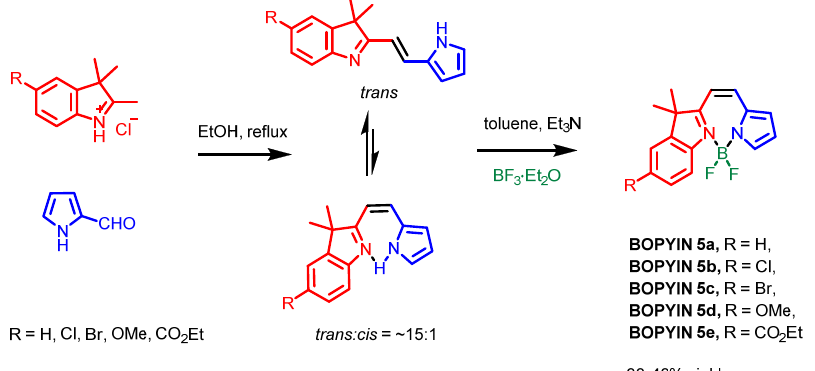
Figure 4. Confocal microscopy colocalization images of HeLa cells stained with BODIPYs 3 and 4 , and MTG. ( a , d ) MTG under a green channel (488 nm), ( b , e ) BODIPYs 4 and 3 under a red channel, and ( c , f ) merged images. Adapted from [21].